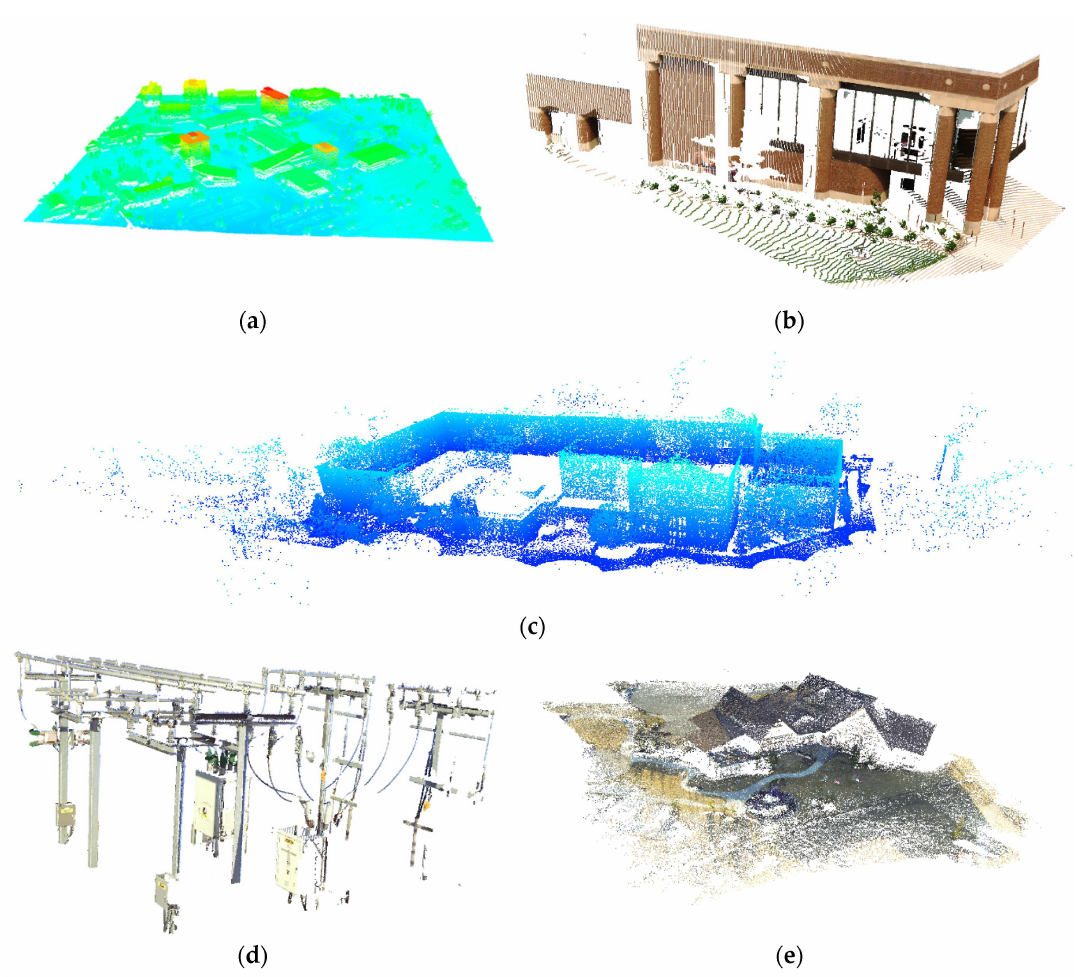
Figure 8. Perspective views of the point clouds from the ALS ( a ); TLS1 ( b ); TLS2 ( c ); TLS3 ( d ); and DIM ( e )